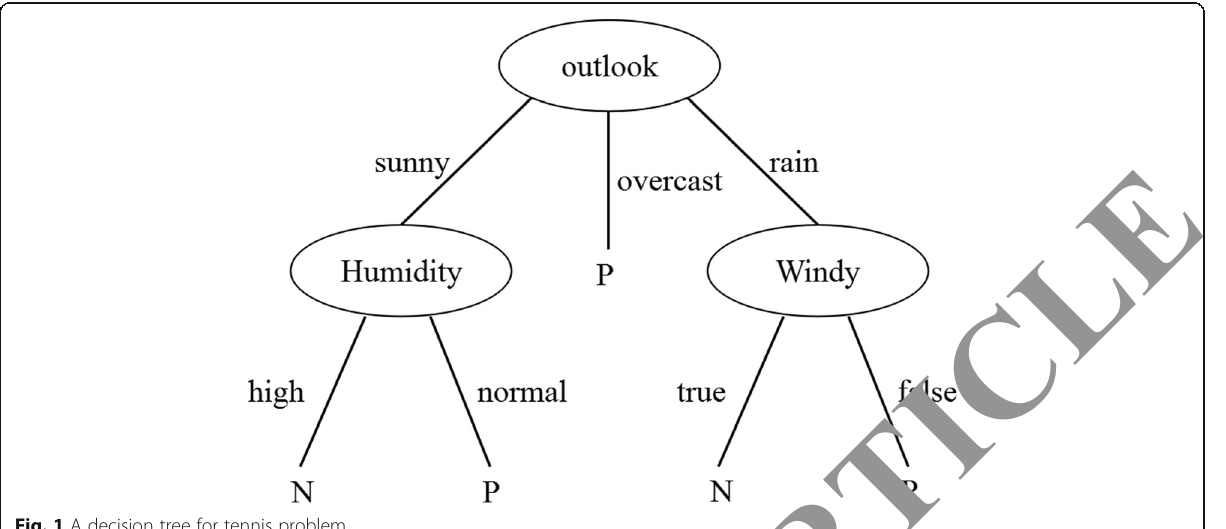
Fig. 1 A decision tree for tennis problem